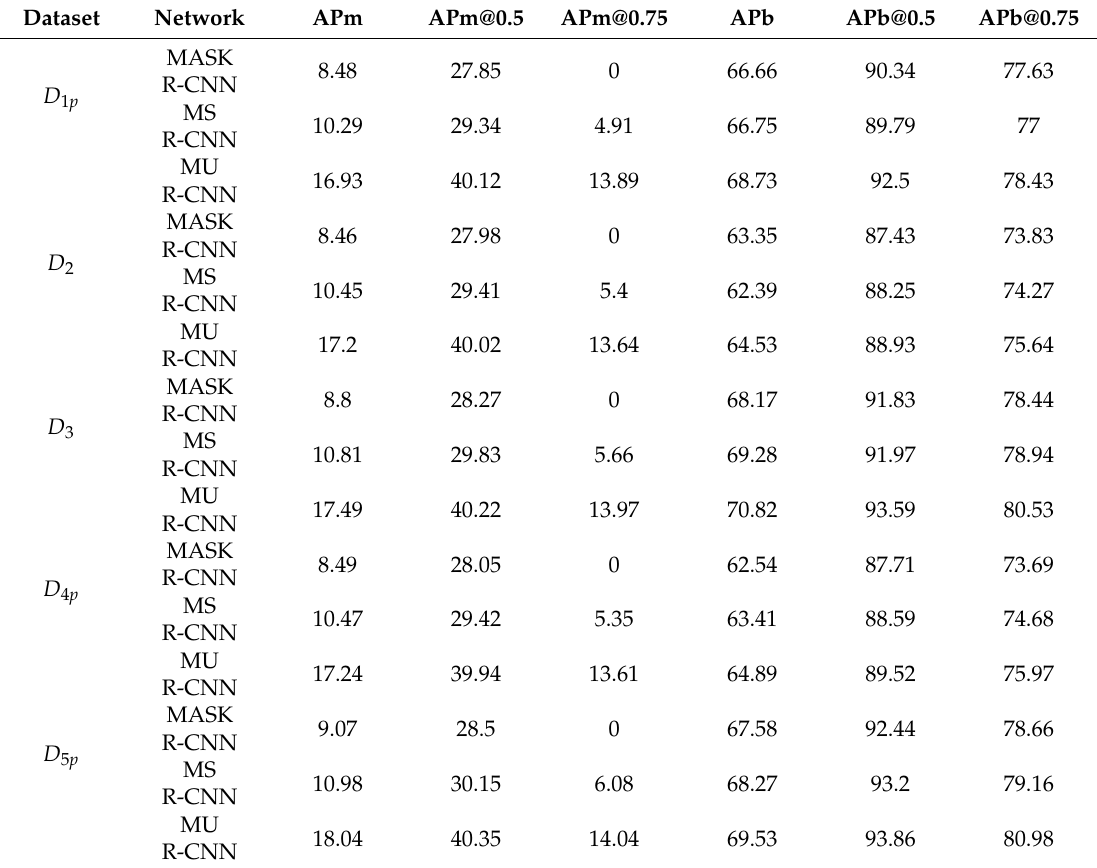
Table 6. Comparing MU R-CNN and related networks in D 1p , D 2 , D 3 , D 4p and D 5p dataset.